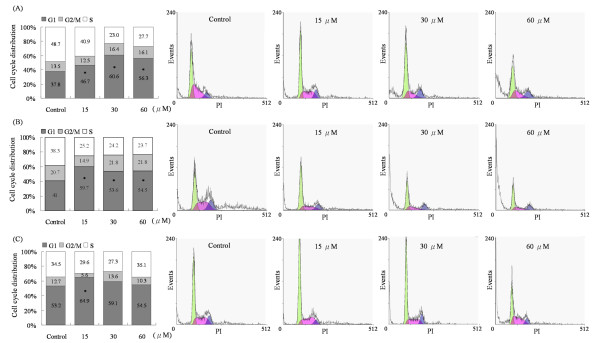
Squamocin induced cell cycle arrest at the G1 phase. Cells were treated with 15, 30, and 60 μM squamocin for 24 h, and then cells were stained with propidium iodide (PI) and analyzed for DNA content by flow cytometry. G1, S, and G2/M indicate cell phase. Cells without squamocin treatment served as a control. (A) GBM841 cells. (B) Huh-7 cells. (C) SW620 cells. Data are the mean of three independent experiments. * p < 0.05, compared to the control.